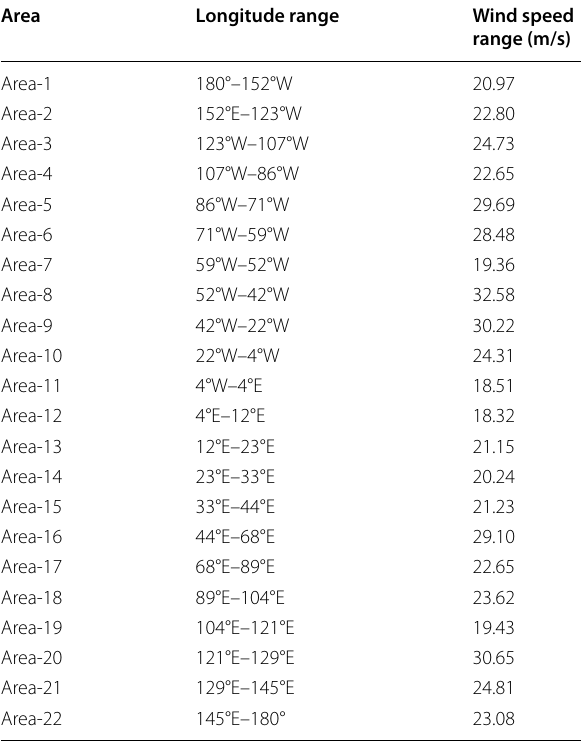
Table 1 The specific information of each